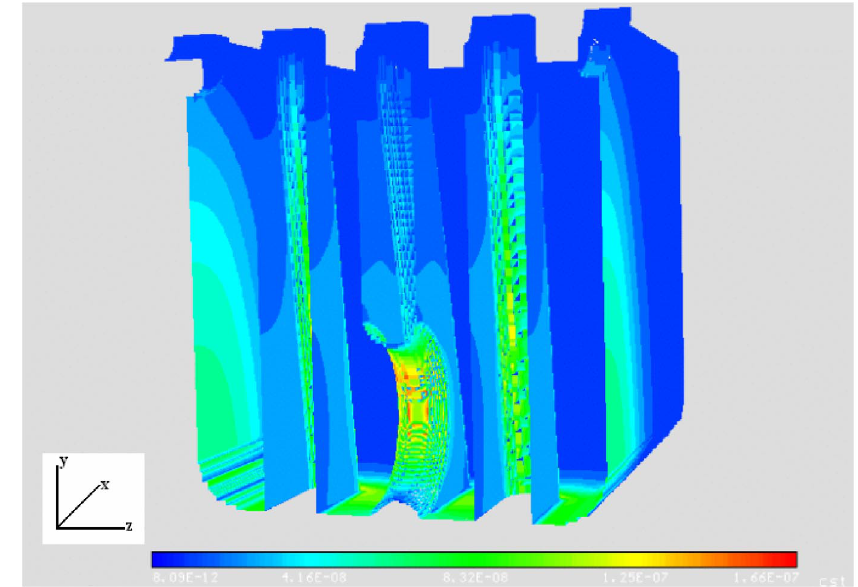
FIG. 6. (Color) 3D plot of the magnetic field on a quarter of the resonator internal surface, as calculated by M.A.F.I.A. It can be noted that the higher fields are concentrated in the portion of the resonator among the stems and they are vanishing towards the x is located in the coupling direction, where it was chosen to locate the flanged joint; B s;p